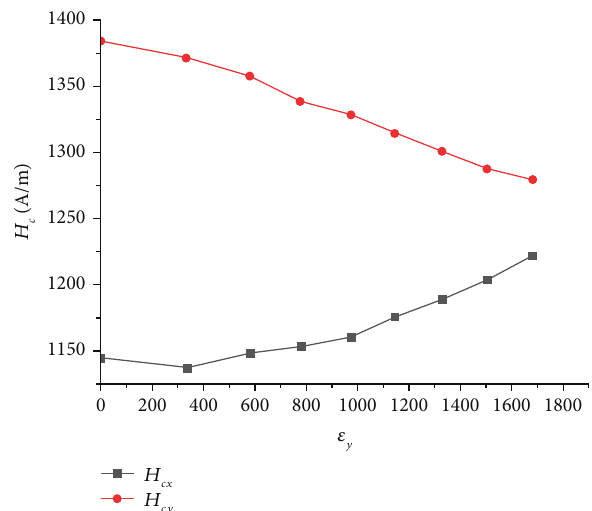
Figure 4: Coercive force-strain relationship under uniaxial stress